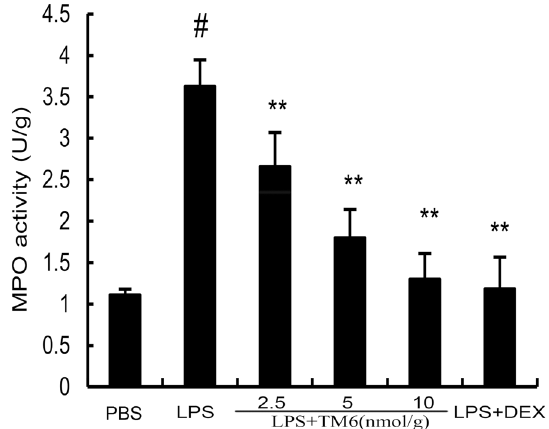
Figure 4. The effect of TM6 on cytokines production in BALF. Mice were given an intraperitoneal injection of TM6 (2.5, 5 and 10 nmol/g) and DEX (5 mg/kg) 1 h prior to an i.n. administration of LPS. BALF was collected 7 h following LPS challenge to analyze the inflammatory cytokines TNF- α , IL-1 β , and IL-6. The values presented are means ± SEM (n = 6). # P < 0.01 is significantly different from the control group; * P < 0.05 and ** P < 0.01 are significantly different from the LPS